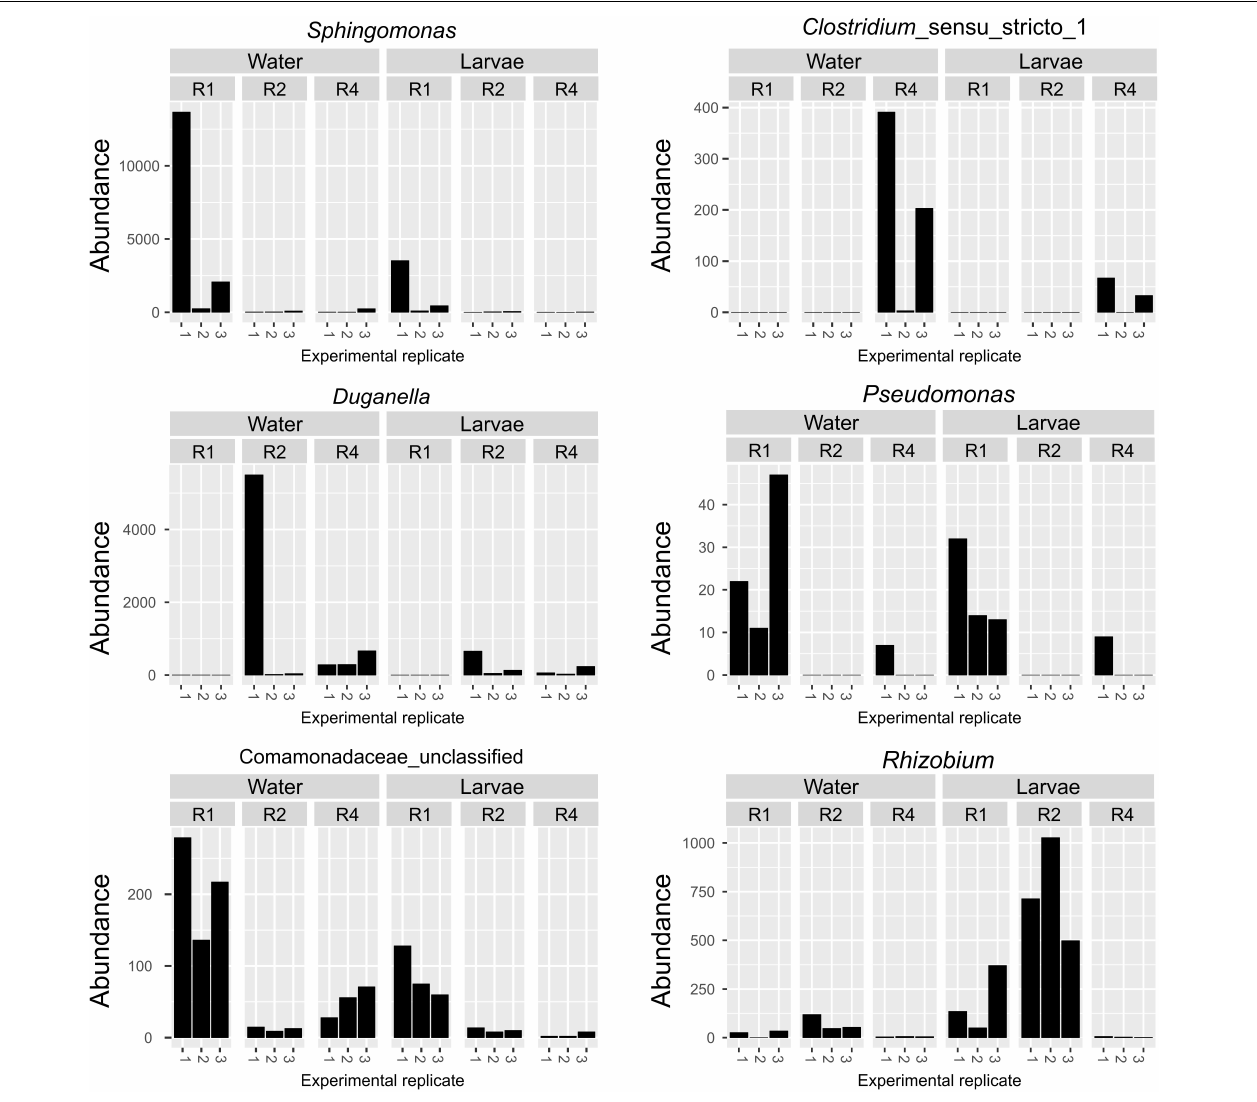
FIGURE 7 | Specific OTUs are significantly affected by larval diet amount in breeding water and larvae only. Abundance of six OTUs was significantly affected by diet amounts in breeding water and larval samples. For each OTU, abundance is plotted for each sample type, diet treatment and biological